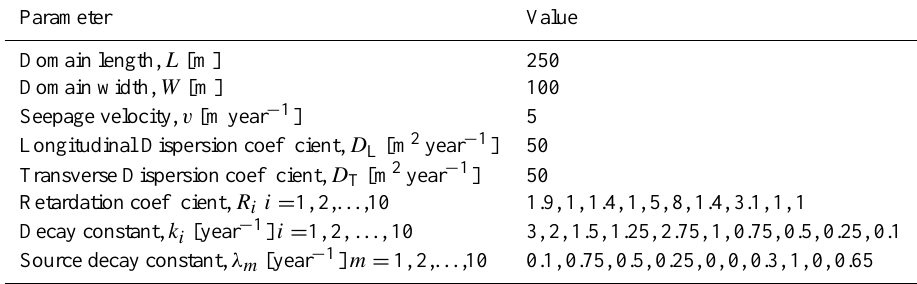
Table 9. Coefficients of Bateman-type boundary source for ten-species transport problem used by Srinivasan and Clement (2008b). Species, i b im m = 1 m = 2 m = 3 m = 4 m = 5 m = 6 m = 7 m = 8 m = 9 m =